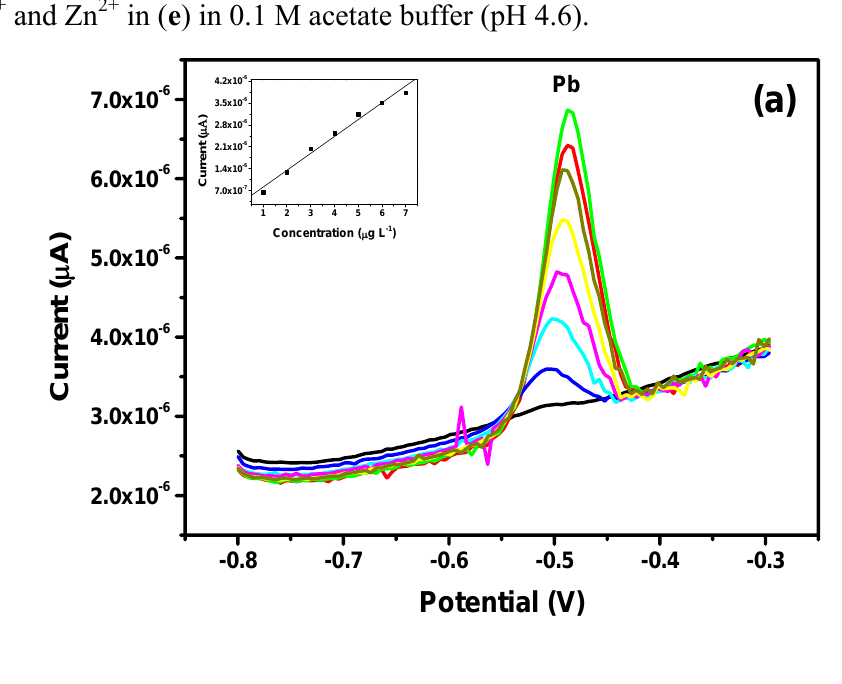
Figure 8. SWASVs of ( a ) Pb 2+ , ( b ) Cd 2+ , ( c ) Zn 2+ , ( d ) Cu 2+ and simultaneous analysis of Pb 2+ , Cd 2+ and Zn 2+ in ( e ) in 0.1 M acetate buffer (pH